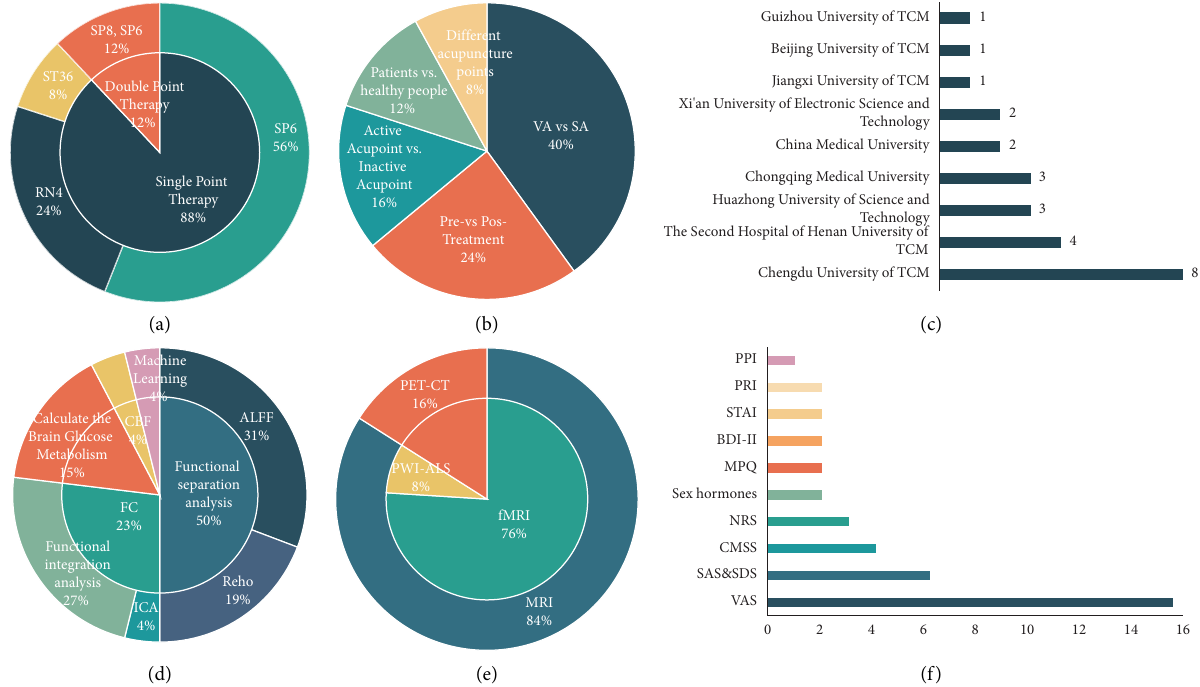
Figure 1: Te study design included (a) the proportion of diferent types of acupuncture points, (b) the proportion of the type of control of PD, (c) the proportion of institutions, (d) the proportion of analysis methods of neuroimaging data, (e) the proportion of scanning techniques, and (f) the proportion of clinical scale of PD. VA: verum acupuncture; SA: sham acupuncture; CBF: cerebral blood fow; ALFF: amplitude of low-frequency fuctuations; FC: functional connectivity; ReHo: regional homogeneity; ICA: independent components analysis; PET-CT: positron emission tomography-computed tomography; MRI: magnetic resonance imaging; fMRI: functional magnetic resonance imaging; PWI: perfusion-weighted imaging; ASL: arterial spin labeling; PPI: present pain intensity; PRI: pain rating index; STAI: state-trait anxiety inventory; BDI-II: beck depression inventory-II; MPQ: McGill pain questionnaire; NRS: numerical rating scale; CMSS: cox menstrual symptom scale; SAS: self-rating anxiety scale; SDS: self-rating depression scale; VAS: visual analog